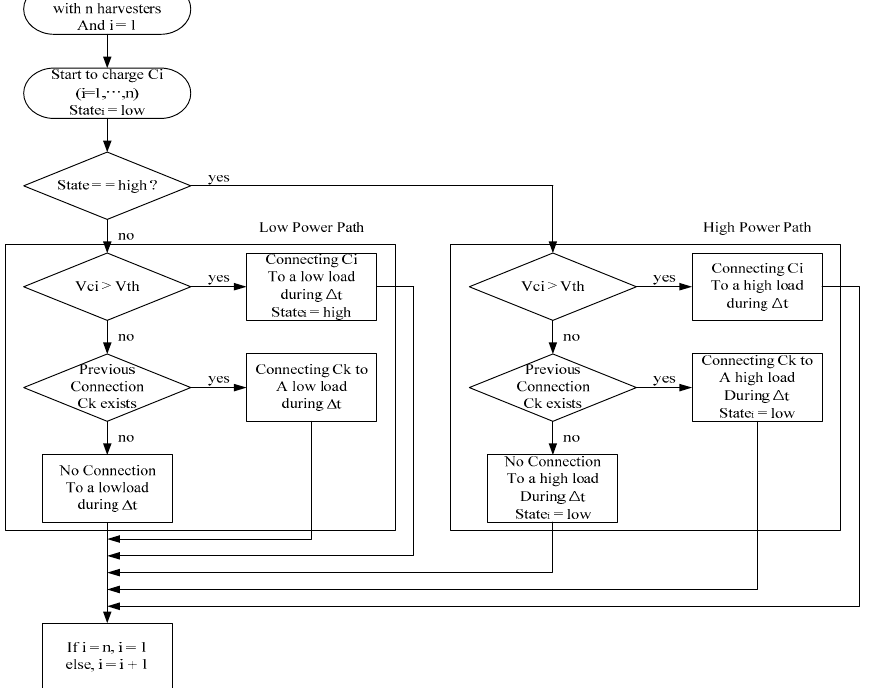
Figure 7. Flowchart for the process of the proposed algorithm.